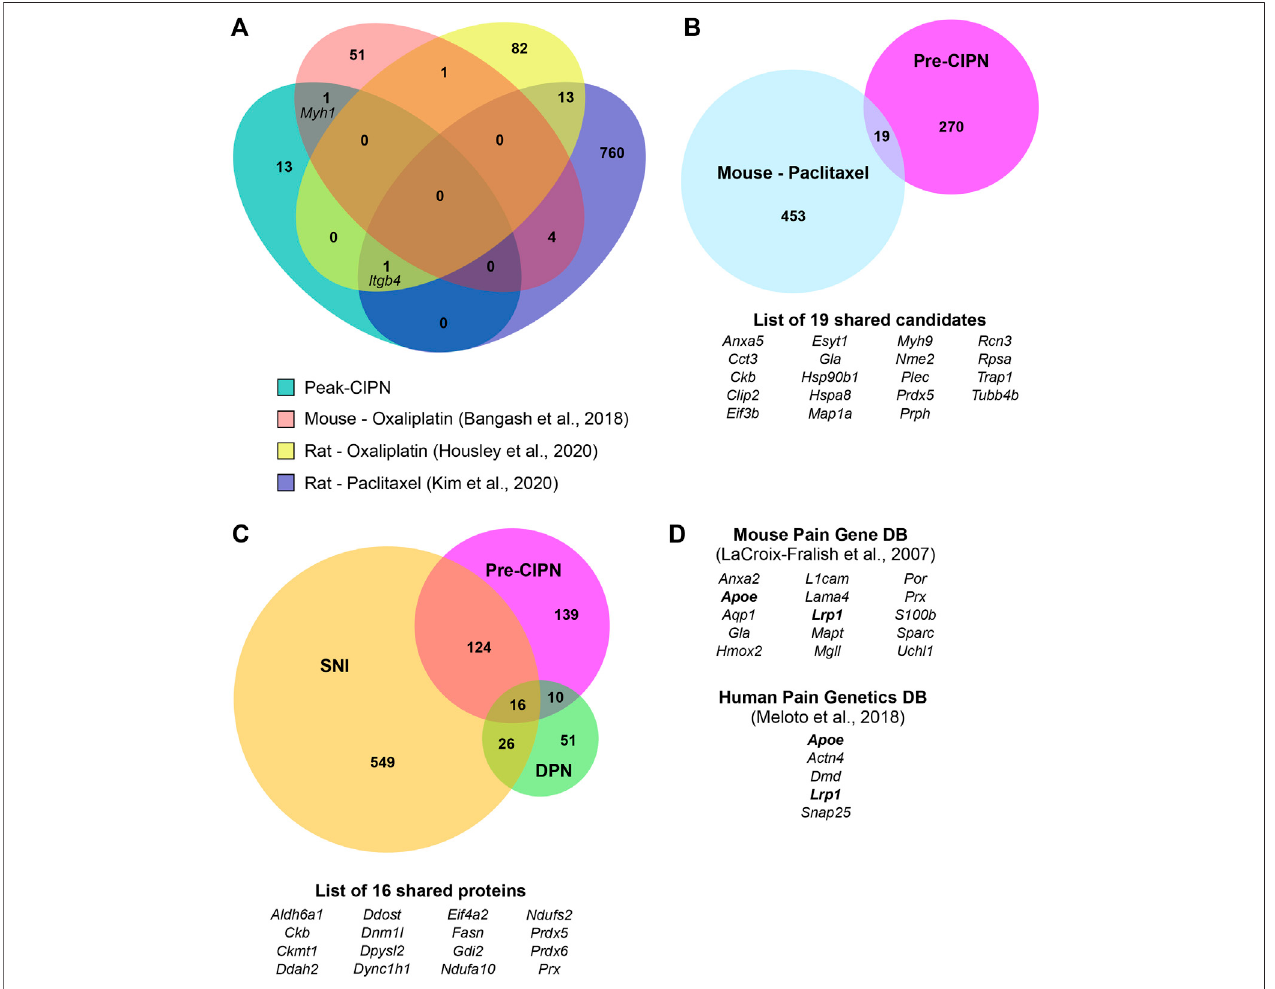
FIGURE 6 | Comparison of our proteome datasets to diverse -omics studies on CIPN and different neuropathy models. (A) Venn Diagram for comparison with transcriptomedatasets followingchemotherapytreatment (Bangashet al.,2018;Housleyetal.,2020;Kim etal.,2020)at peak-CIPN. (B) VennDiagramforcomparison with the regulated translatome following paclitaxel (Megat et al., 2019) at pre-CIPN. (C) Comparison of here reported pre-CIPN-induced proteome alterations with proteome datasets from other chronic pain models: spared nerve inury (SNI) (Barry et al., 2018) and diabetic peripheral neuropathy (DPN) (Akude et al., 2011). Of note, the comparison was performed by gene name, please see methods for details. (D ) List of genes corresponding to differentially regulated proteins that have previously been associated with a pain phenotype in mice or humans. Bold font: genes that are found in both databases.